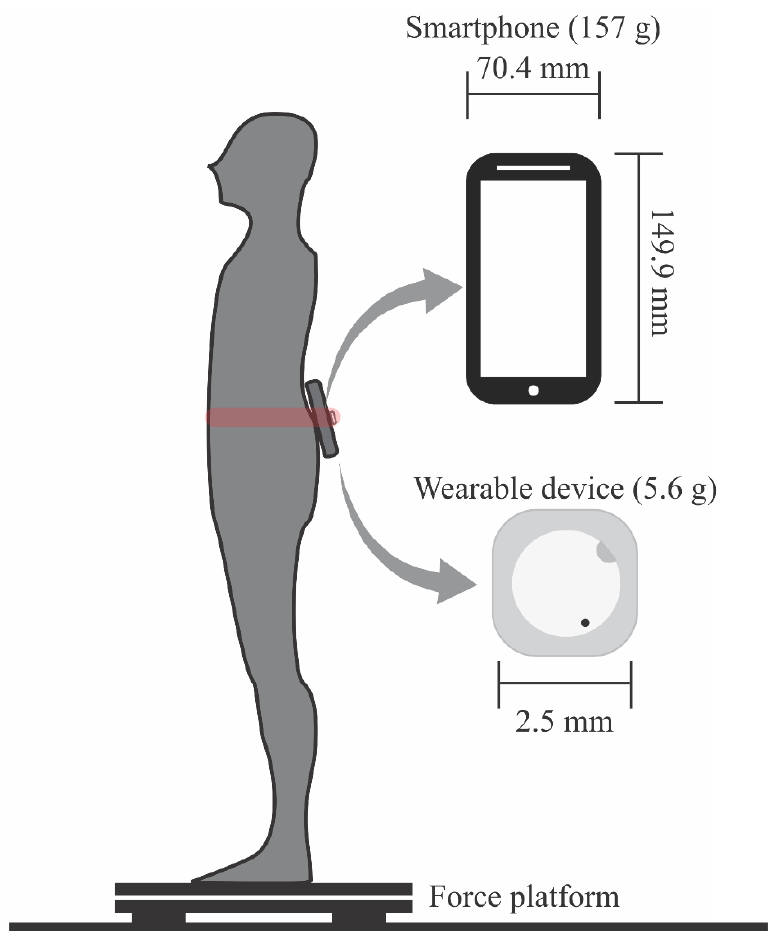
Figure 1. Scheme of the experimental setup. The participant was requested to keep in a quite standing position on a force platform. A smartphone and wearable were fixed in the lumbar region using an elastic strap. Panels highlight the dimensions of the smartphone and wearable device.